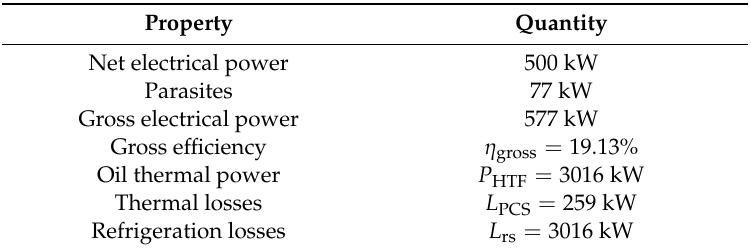
Table 1. Power distribution at the Power Conversion System (PCS).